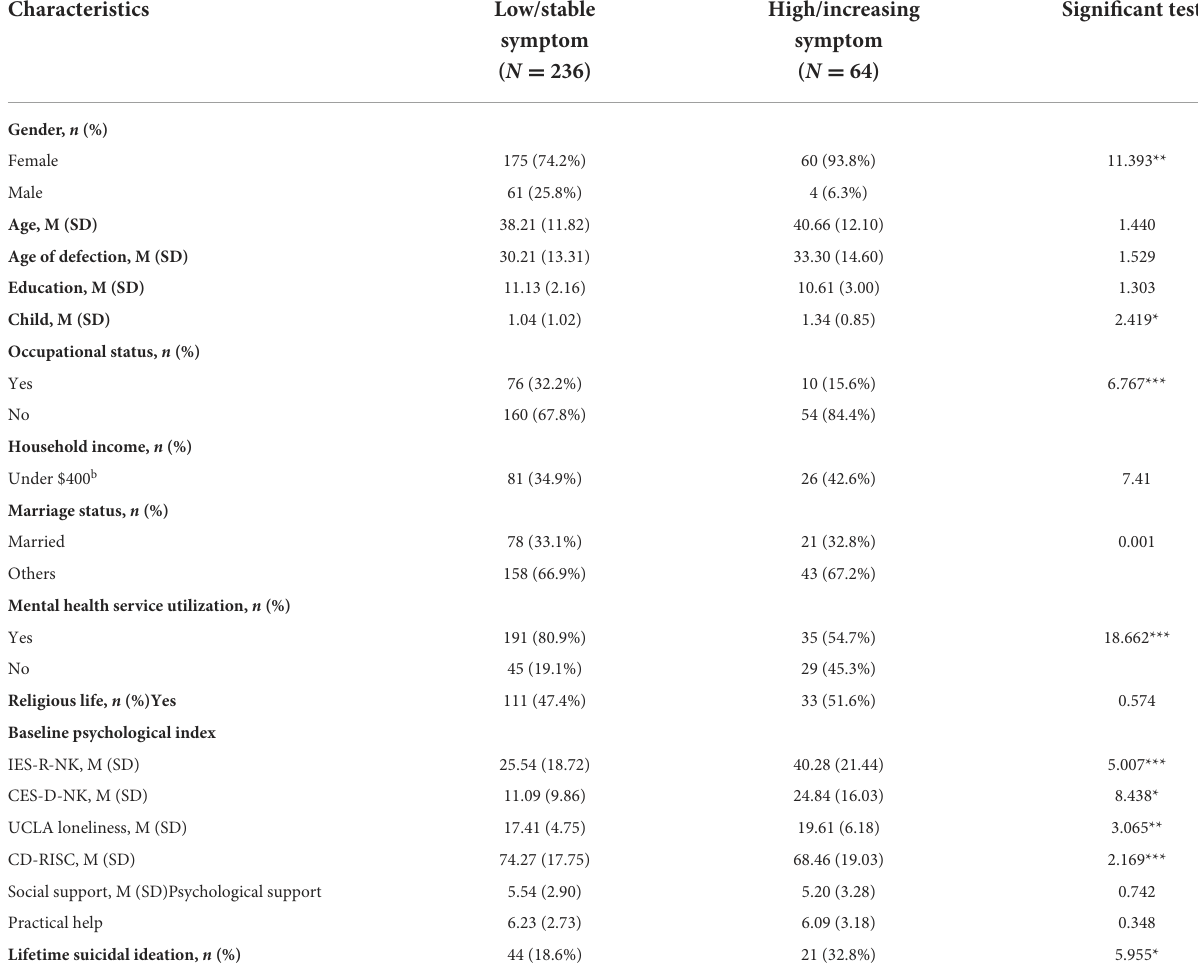
TABLE 3 Between-class comparison of sociodemographic and psychological factors at baseline. Characteristics